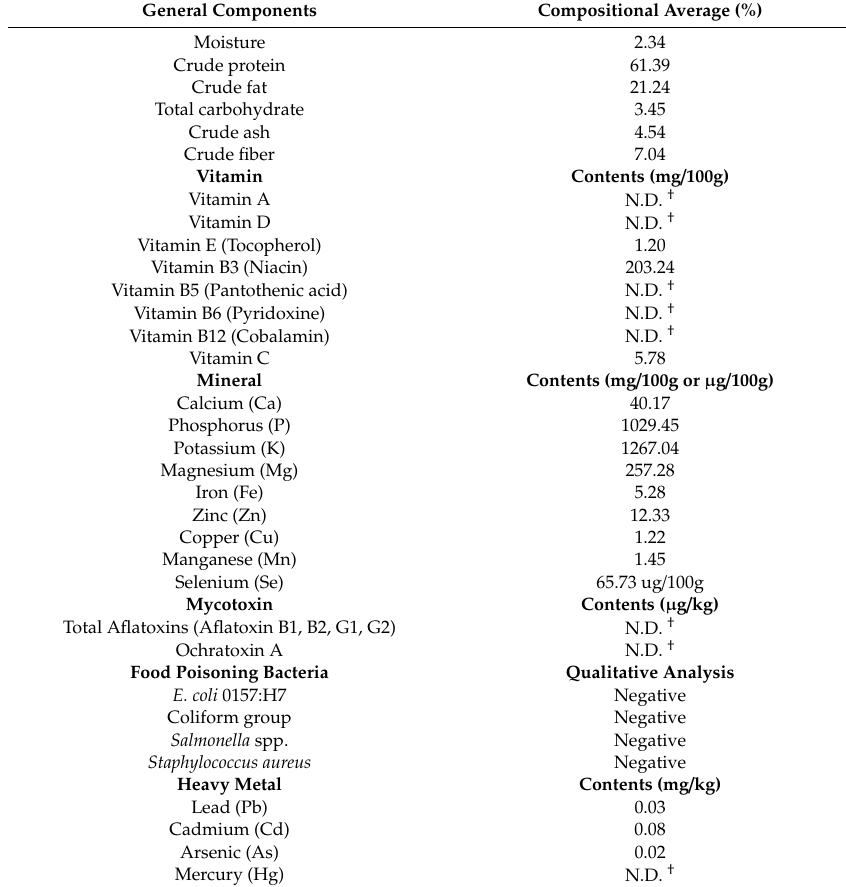
Table 1. The nutritional components of